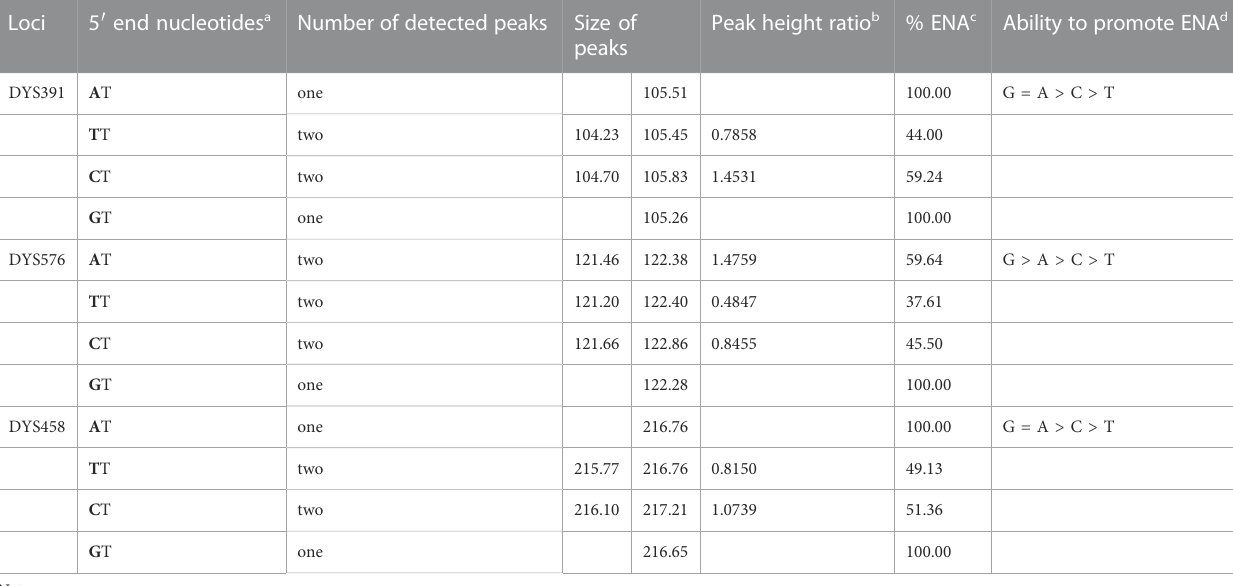
TABLE 2 Primer modi fi cations which in fl uence formation of non-templated nucleotide addition products. Loci 5 ′ end nucleotides